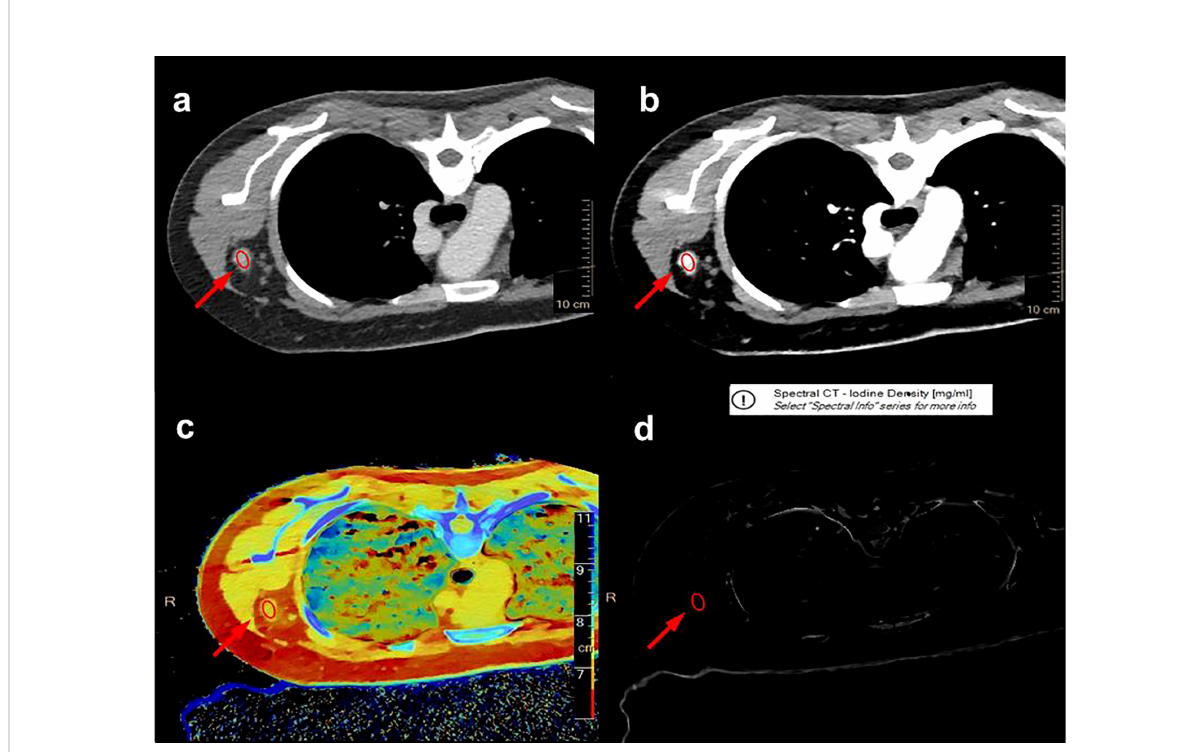
FIGURE 3 A multiplane reconstruction technique was used to place the ROI to cover the entire axillary lymph node (red ellipse) on the IQon 40 keV (A) and 70 keV (B) DLCT images, and quantitative parameters, such as effective atomic number (C) and iodine concentration (D) , were recorded in the arterial and venous phases,